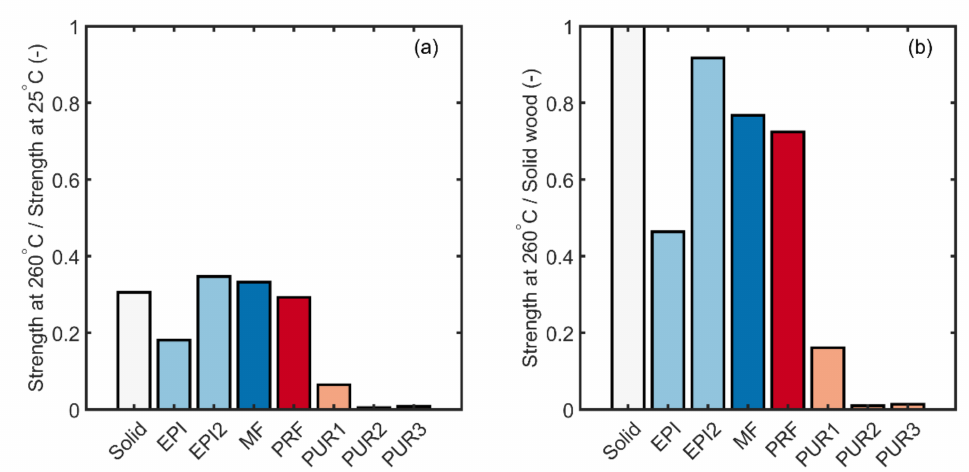
Figure 6. Mean strength at 260 ◦ C normalized to ( a ) strength at room temperature, and ( b ) solid wood at 260 ◦